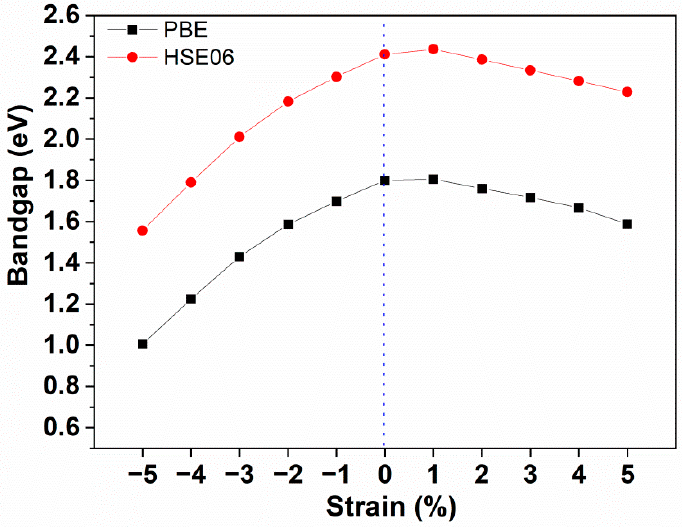
Figure 3. Band gap of 2D polar monolayer SiTe at di ff erent strains.